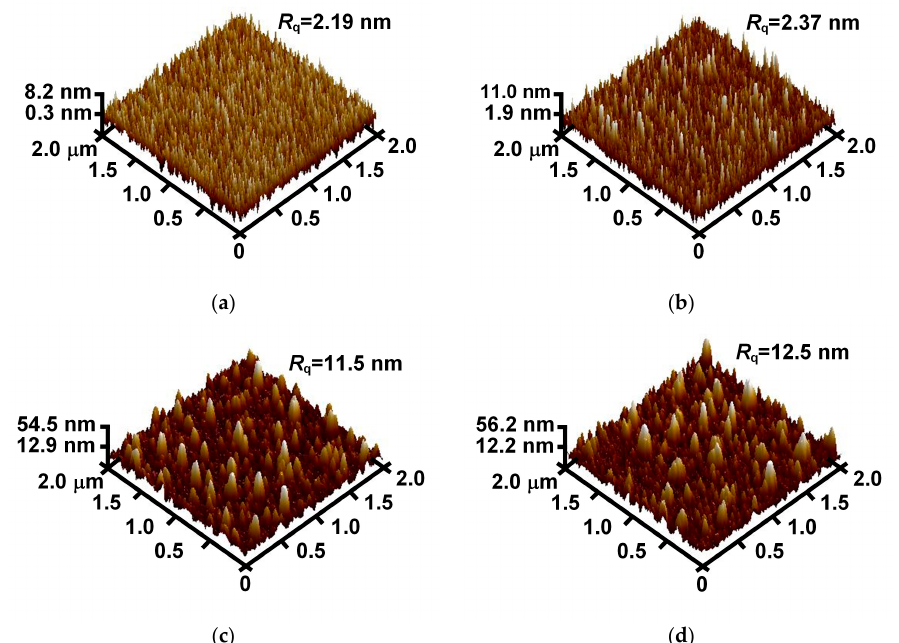
Figure 4. AFM images of ( a ) an undoped MgO film sample and three Au-doped MgO film samples with doping concentrations of ( b ) 1.5%, ( c ) 3.0%, and ( d ) 4.5%.